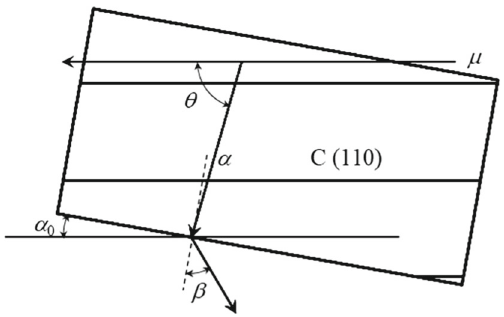
Fig. 9 One possible scheme of muon channeling in a specially fabri- cated crystal